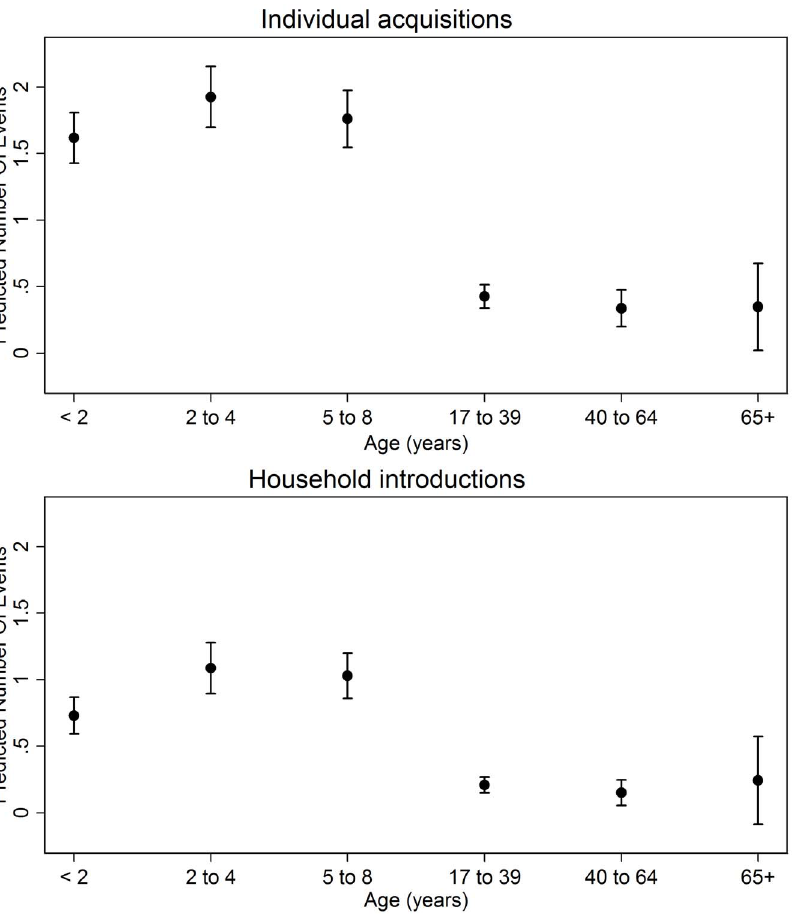
Figure 1. Adjusted number of pneumococcal acquisition events, by age category. Each point represents the mean number of individual acquisitions or household introduction for an individual in a given age category (with 95% confidence interval) over the course of the study, adjusted by all other covariates in the Poisson models set to their means.